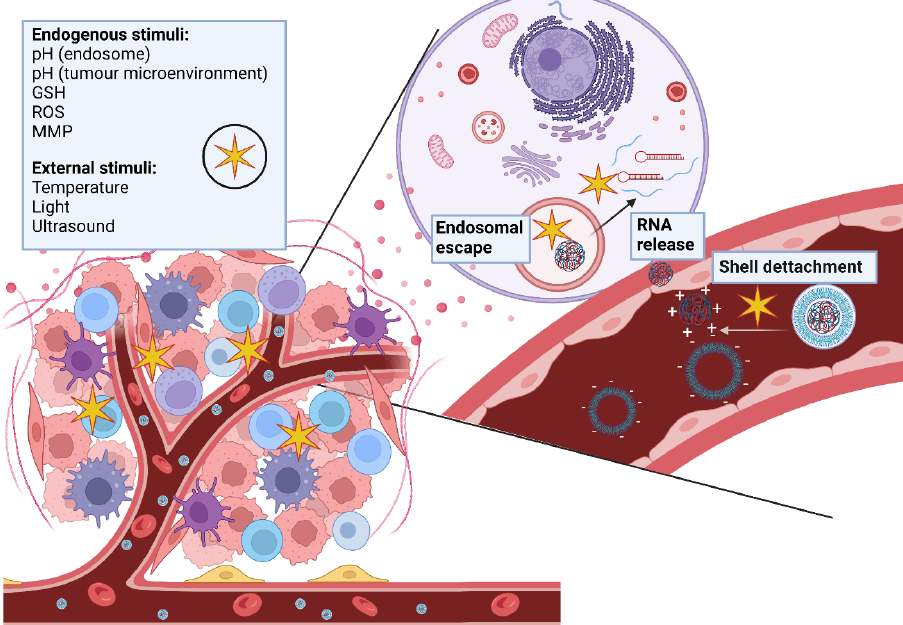
Figure 4. Smart polymeric nanocarriers respond to endogenous and exogenous stimuli which trigger shell detachment, endosomal escape and RNA release into the cytoplasm.